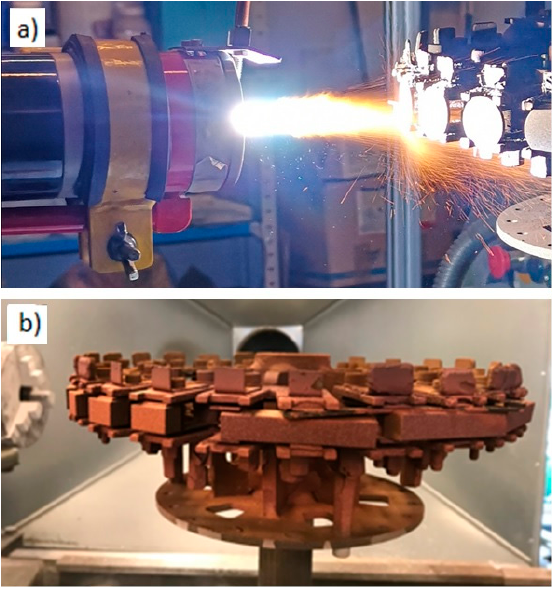
Figure 4. Robotized APS set-up: SG-100 plasma torch under operation ( a ), and sample holder mounted to a welding turntable ( b ).